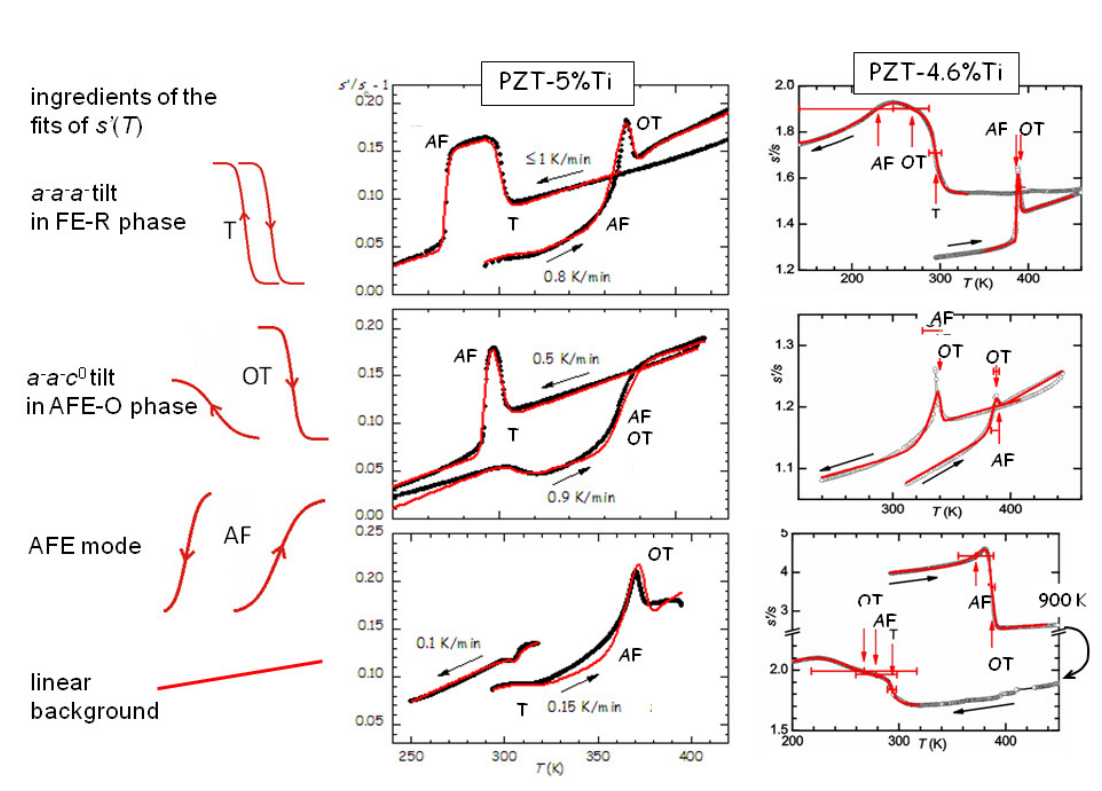
Figure 10. Fits of the elastic anomalies at the AFE/FE transition of PZT with the ingredients indicated on the left. Adapted with permission from Refs. [44,45], copyrighted by the American Physical